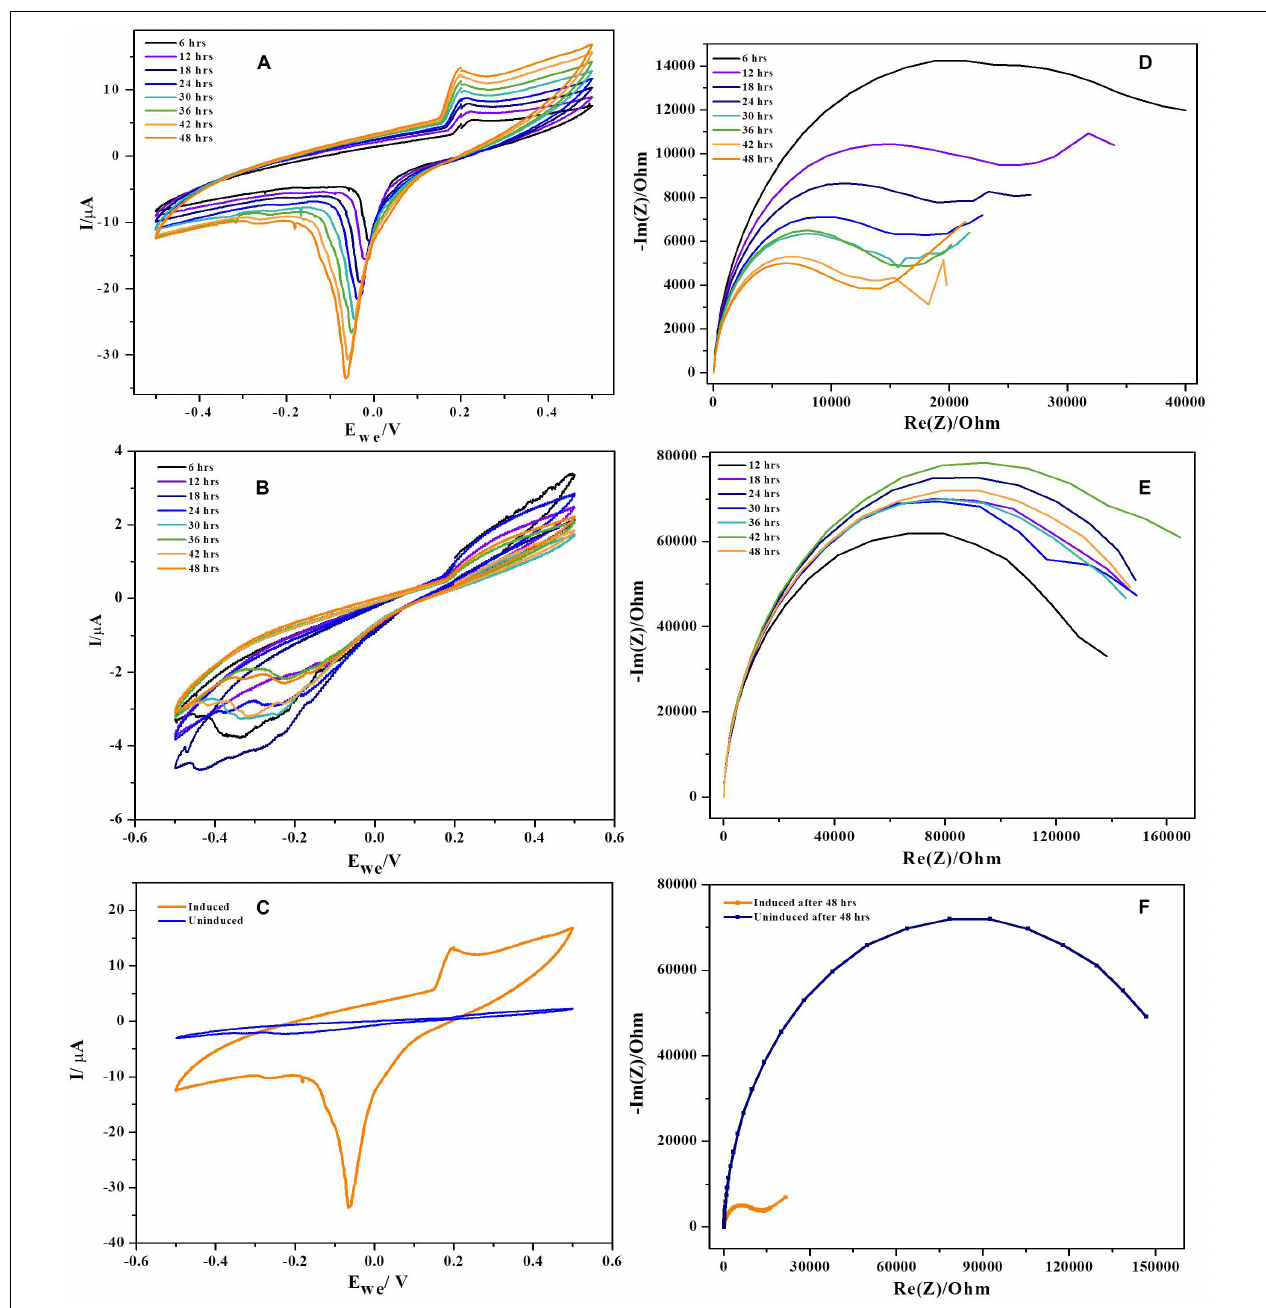
FIGURE 6 | Cyclic voltammograms recorded during 48 h period of time (at every 6 h) at a scan rate of 0.001 Vs − 1 . (A) NDH-2, (B) wild, and (C) combined voltammograms. In case of NDH-2 induced, E 0‘ is shifted significantly negative while uninduced has no peaks produced. Biofilm monitoring by impedance spectroscopy, (D) NDH-2, (E) wild, and (F)